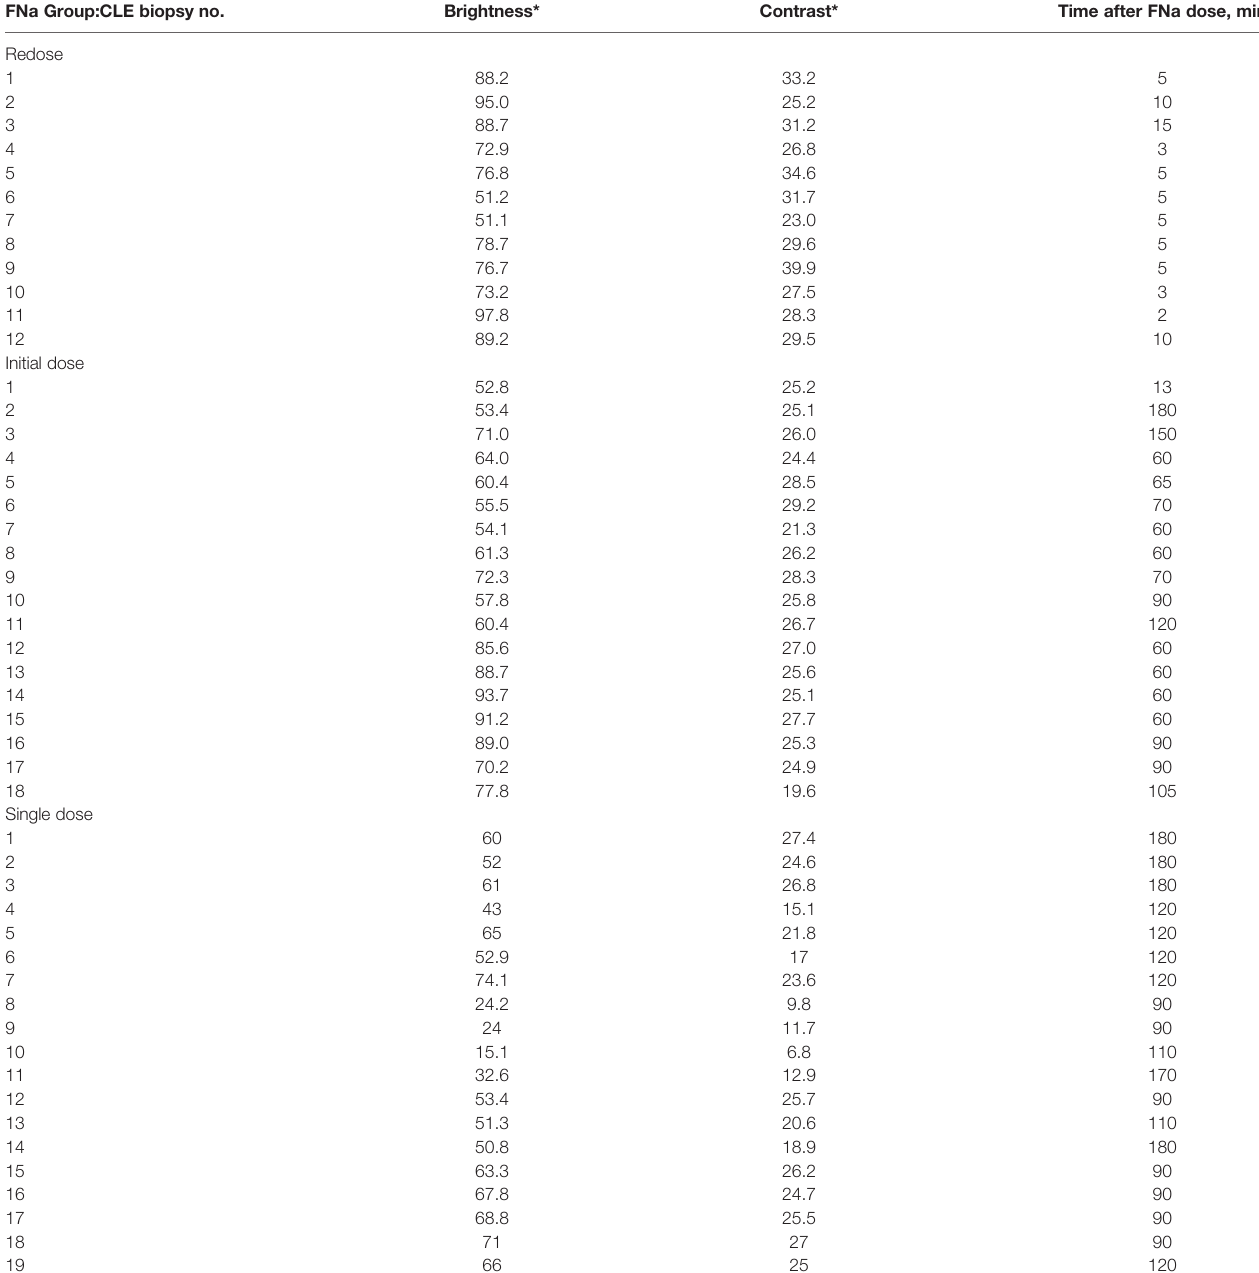
TABLE 1 | Image brightness, contrast, and timing for each CLE optical biopsy by FNa dosing groups. FNa Group:CLE biopsy no. Brightness* Contrast* Time after FNa dose, min Redose